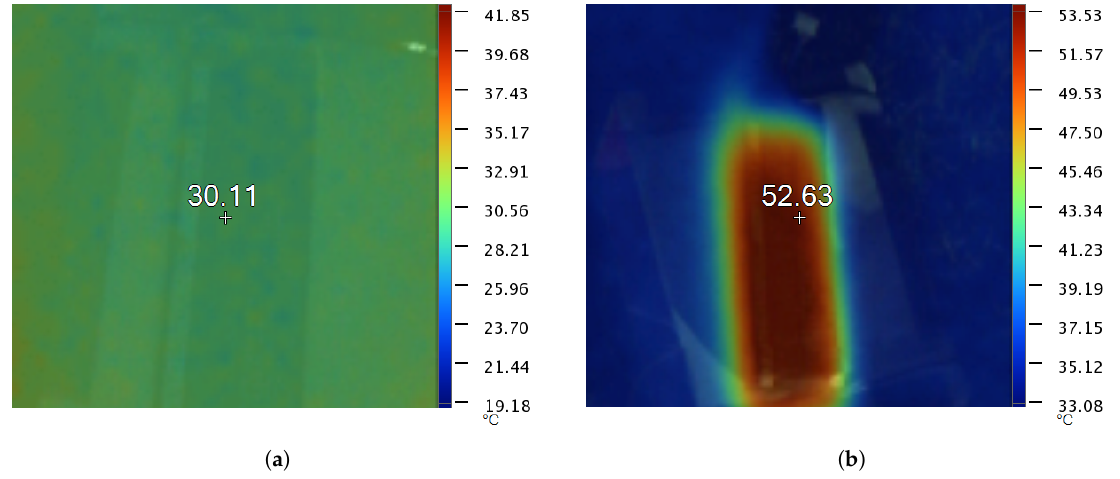
Figure 10. ( a ) Temperature of battery before flight; ( b ) temperature of battery after flight. Flight test 1—increase in battery temperature without any cooling, captured by thermal imaging device